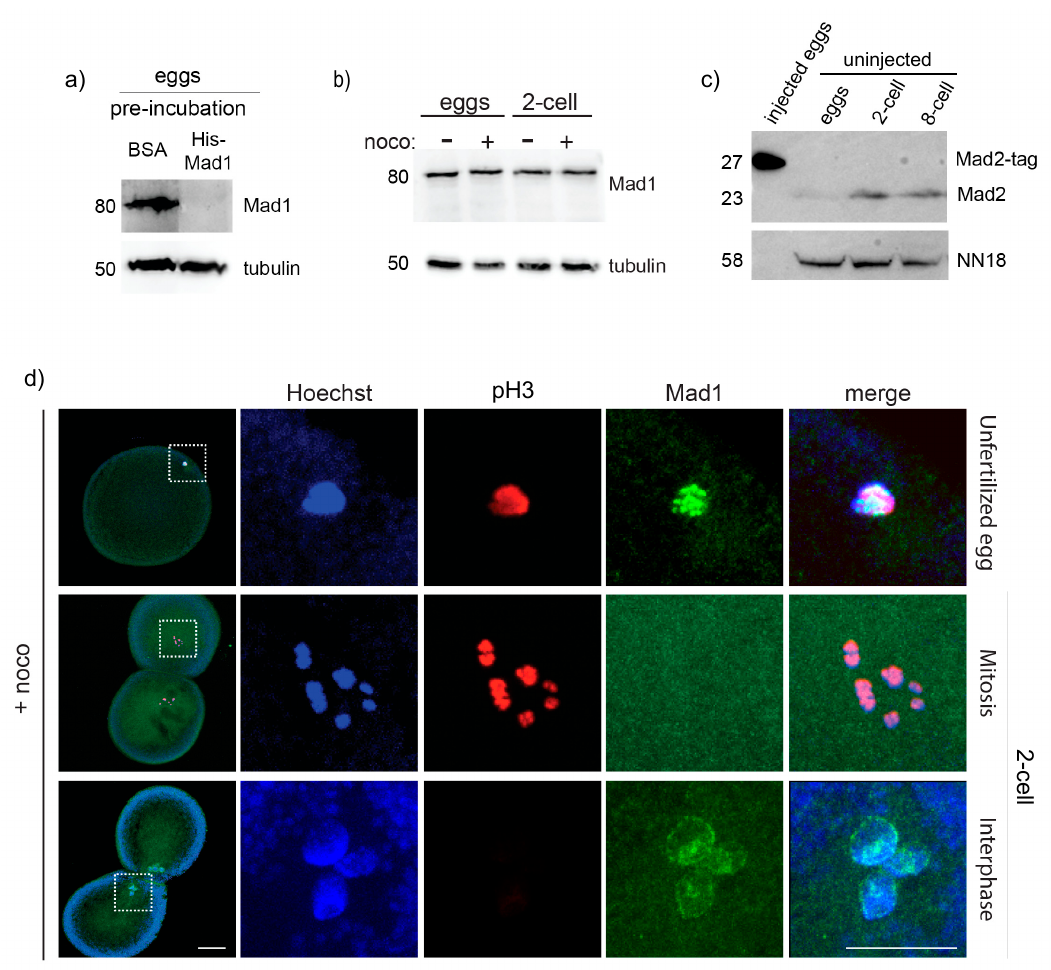
Figure 6. Mad1 does not localize to unattached kinetochores in 2-cell P. mammillata embryos. ( a ) Mad1 antibody recognizes a single 80 KDa protein in P. mammillata egg extract which is specifically lost (top panel) in competition assays when incubated with purified His-Mad1, but not with the equivalent amount of BSA (15 µg), whereas tubulin levels (bottom panel) are unaffected. ( b ) Mad1 level is constant in both untreated and nocodazole-treated eggs and 2-cell embryos. ( c ) Mad2 antibody recognizes a single 23 KDa protein in P. mammillata eggs, 2-cell and 8-cell embryos, and a larger band of the correct size (27 KDa) when tagged Mad2 protein is overproduced by microinjection (left lane: 5 eggs injected with mRNA encoding Mad2 fused to 36 additional amino acids). ( d ) Representative images of nocodazole-treated eggs (top) and 2-cell embryos (middle and bottom panels) stained for Hoechst (blue), Mad1 (green), and pH3 (red). White squares in ( d ) indicate chromatin-containing regions enlarged (5×) on the right images. Scale bar = 30 µm.